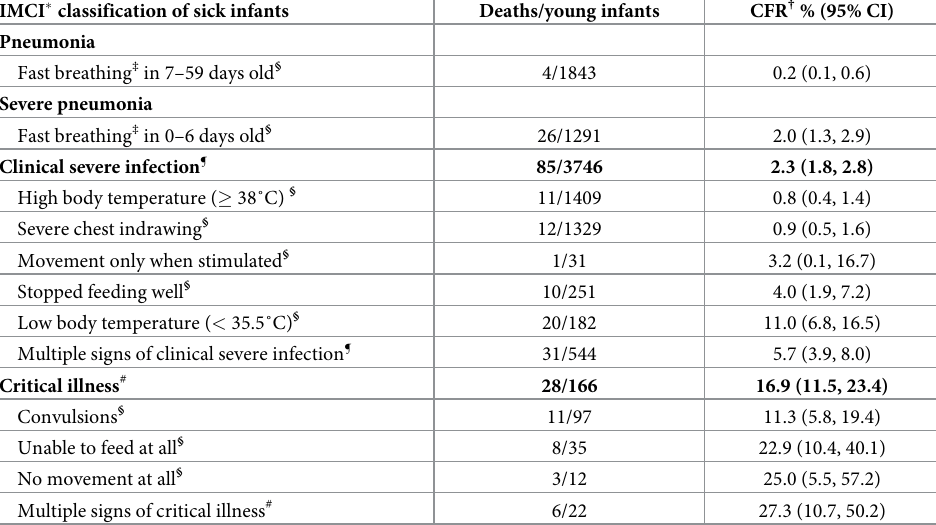
Table 2. Number of deaths, cases and case fatality ratio (CFR) of sick young infants by IMCI � classification [23] (n =